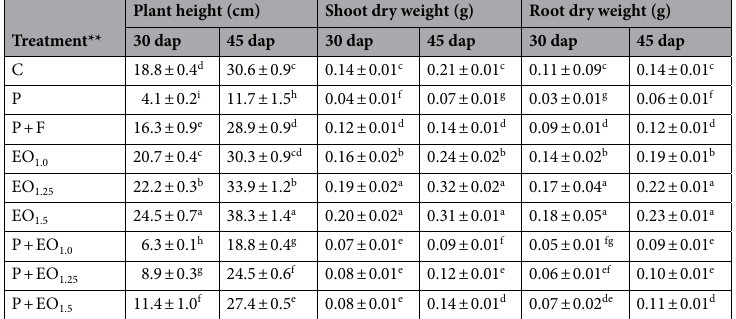
Table 4. Growth parameters of sorghum plants infected with Fusarium solani in response to treating with lavender essential oil at different concentrations. Values followed by the same letter are not significantly different according to Duncan’s multiple range test ( P ≤ 0.05), each value represents the mean of 3 replicates ± SD. **C: untreated control, P: infected with F. solani , P + F: infected with F. solani and treated with chemical fungicide (Rhizolex-T), EO 1.0 , EO 1.25 , EO 1.5 : treated with lavender EO at 1.0, 1.25, and 1.5% respectively, P + EO 1.0 , P + EO 1.25 , P + EO 1.5 : infected with F. solani and treated with lavender EO at 1.0, 1.25, and 1.5%, respectively, and dap: days after